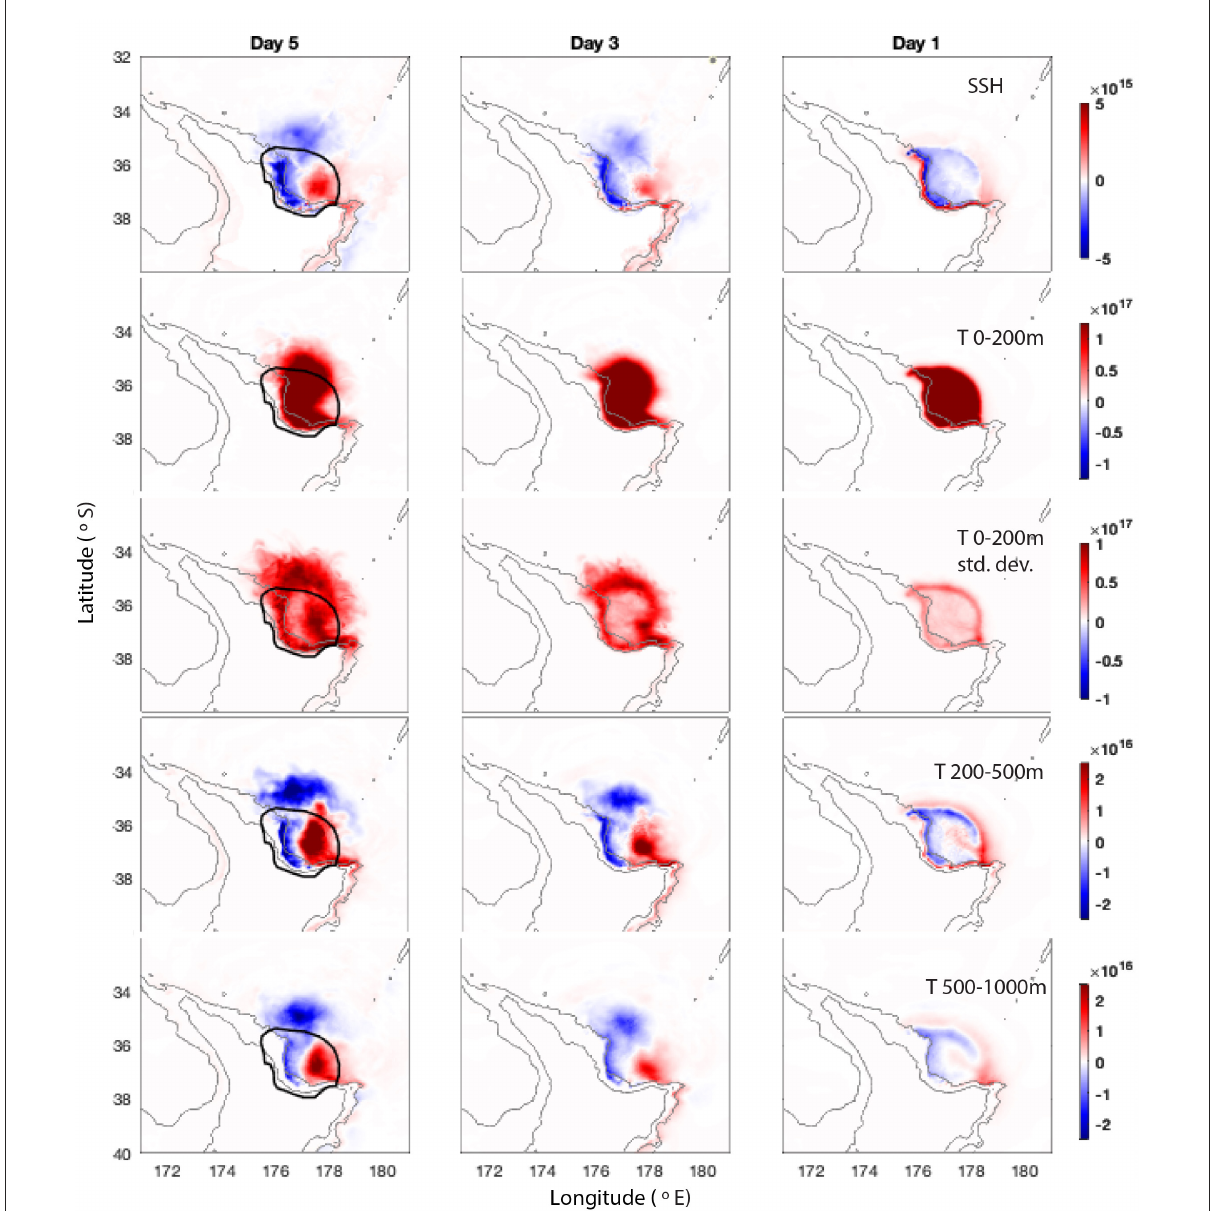
FIGURE8 Ensemble sensitivities for days 5, 3, and 1 leading up to all 64 MHW events in the Bay of Plenty. (Top to bottom) : Mean scaled sensitivity to SSH, mean scaled sensitivity to temperature from 0 to 200 m, standard deviation of scaled sensitivity to temperature from 0 to 200 m, mean scaled sensitivity to temperature from 200 to 500 m and mean scaled sensitivity to temperature from 500 to 1,000 m. Sensitivities are scaled by the 5-day standard deviations for the days leading up to the MHWs, averaged in quadrature. Gray lines show the 100 and 1,000 m bathymetry